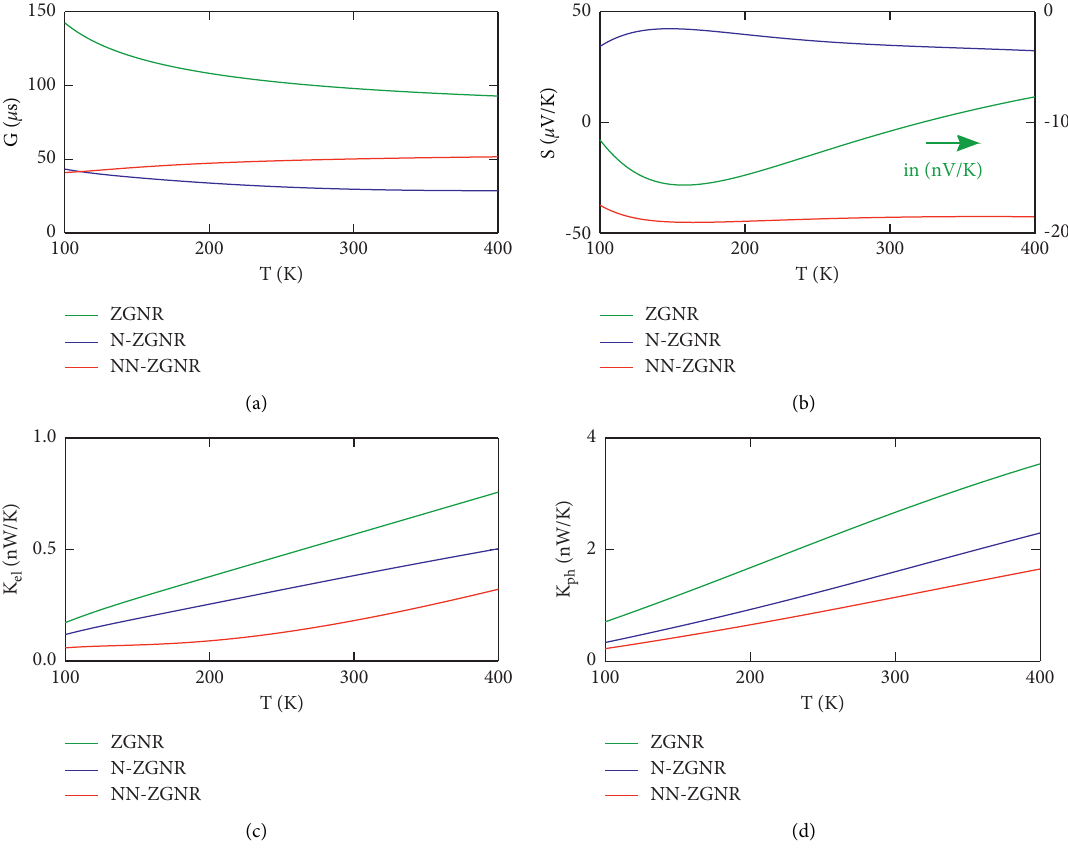
Figure 3: Temperature dependency of electrical conductance (a), thermopower (b), electron contribution to the thermal conductance (c), and phonon contribution to the thermal conductance (d) calculated for the ZGNR (green), N-ZGNR (blue), and NN-ZGNR (red) systems. The colored arrow in panel B indicates that the corresponding curve is depicted against the y2-axis